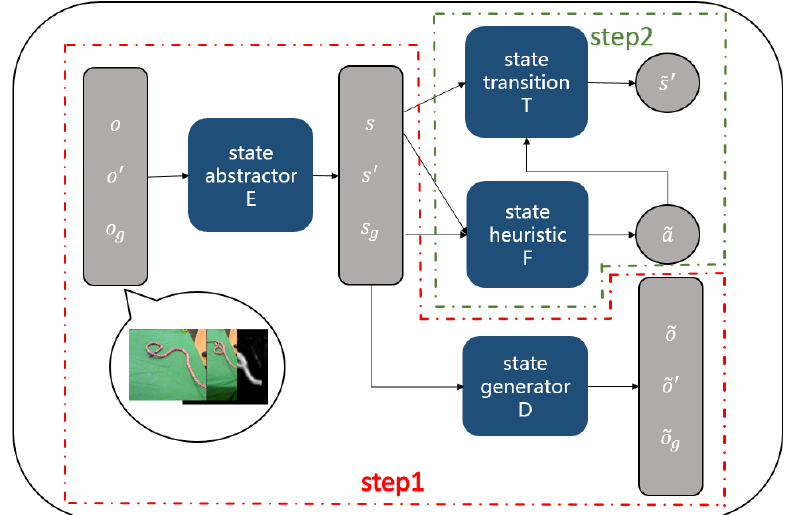
Figure 2. The framework of our action generative network ( AGN